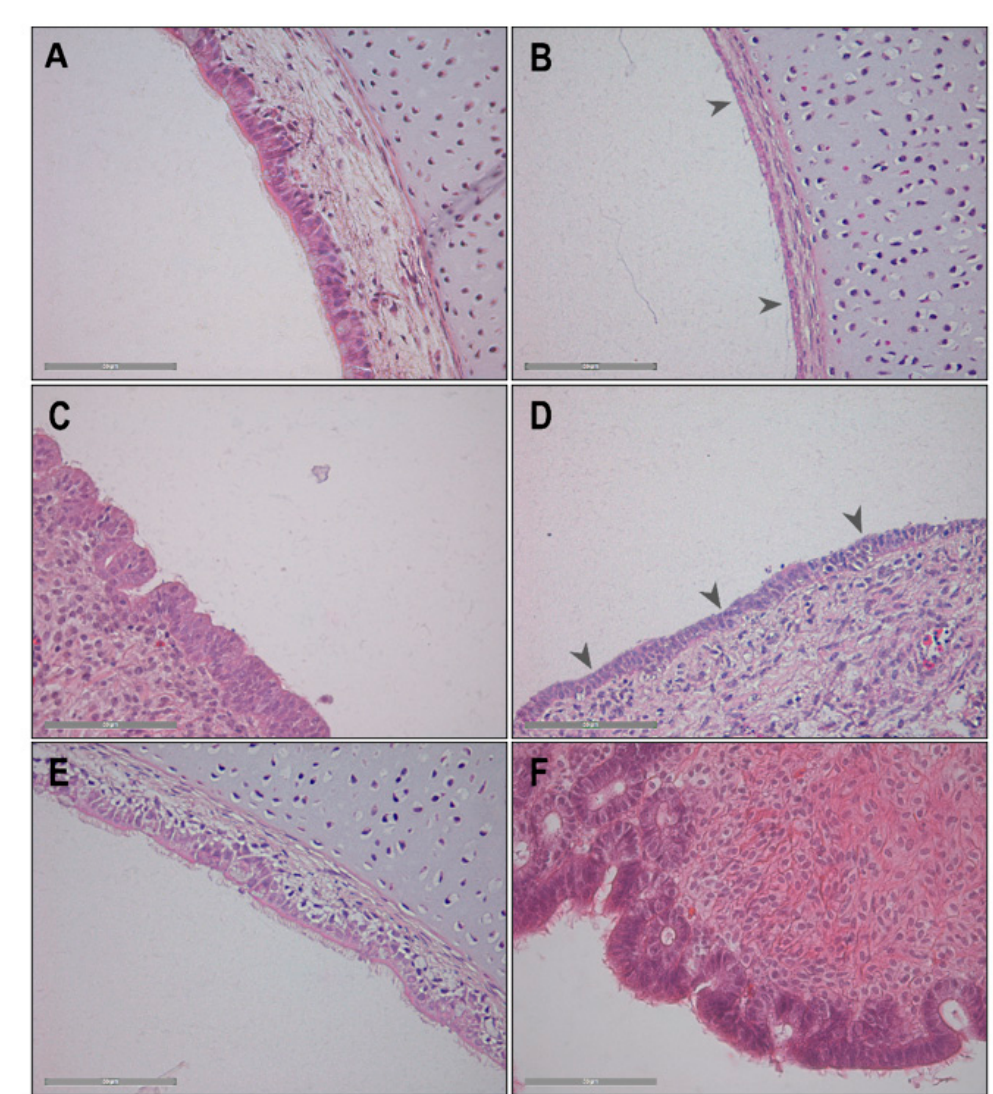
Figure 5. Histopathological lesion development at the epithelial surface of TOCs ( A , B ) and OOCs ( C , D ). Images are AMPV-B-infected TOCs at ( A ) 24 hpi and ( B ) 72 hpi, and NDV-HS-infected OOCs at ( C ) 24 hpi and ( D ) 96 hpi. ( E ) TOC and ( F ) OOC illustrate virus-free rings at time point 96 hpi. Arrowheads highlight cilia loss. The scale bar is 50 µm.